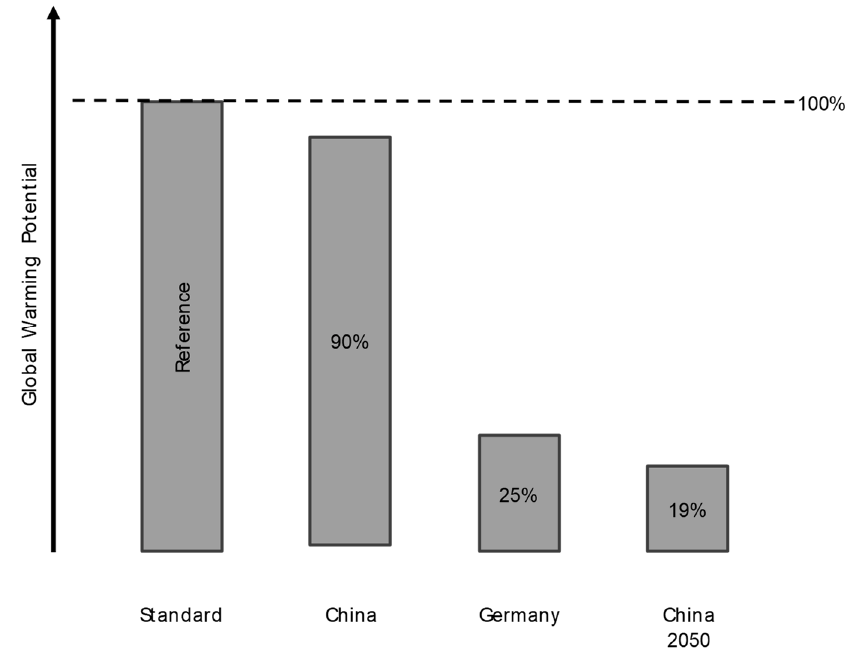
Figure 6. Environmental impacts (i.e., Global Warming Potential) of PERC photovoltaic (PV) for the different scenarios compared to the results of the standard LCA procedure as a reference case.